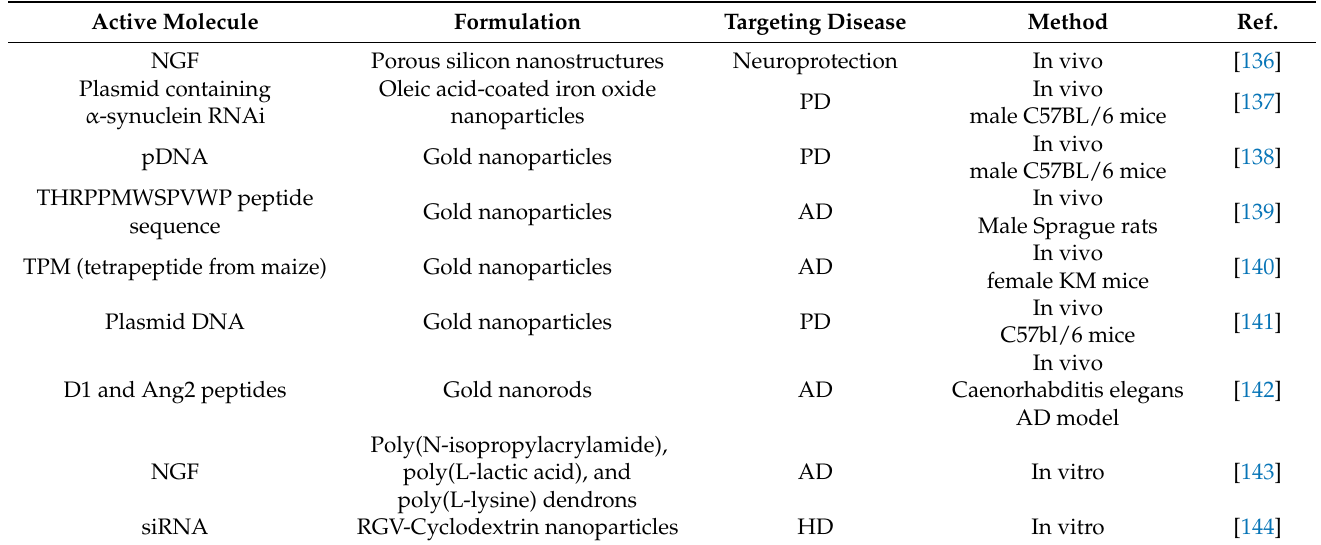
Table 3. Pharmaceutical formulations with proteins and genes targeting neurodegenerative disorders using other